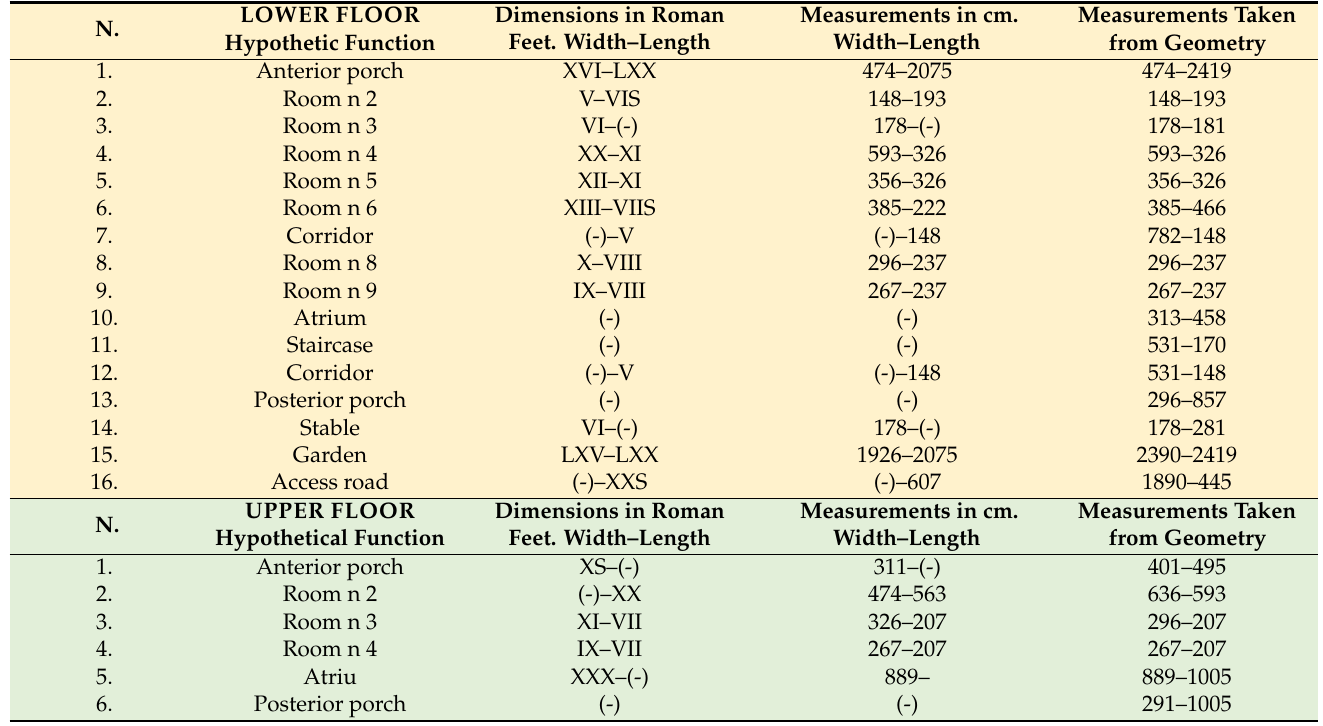
Table 1. The analysis of the dimensions engraved on the slab and the calculation of the correct